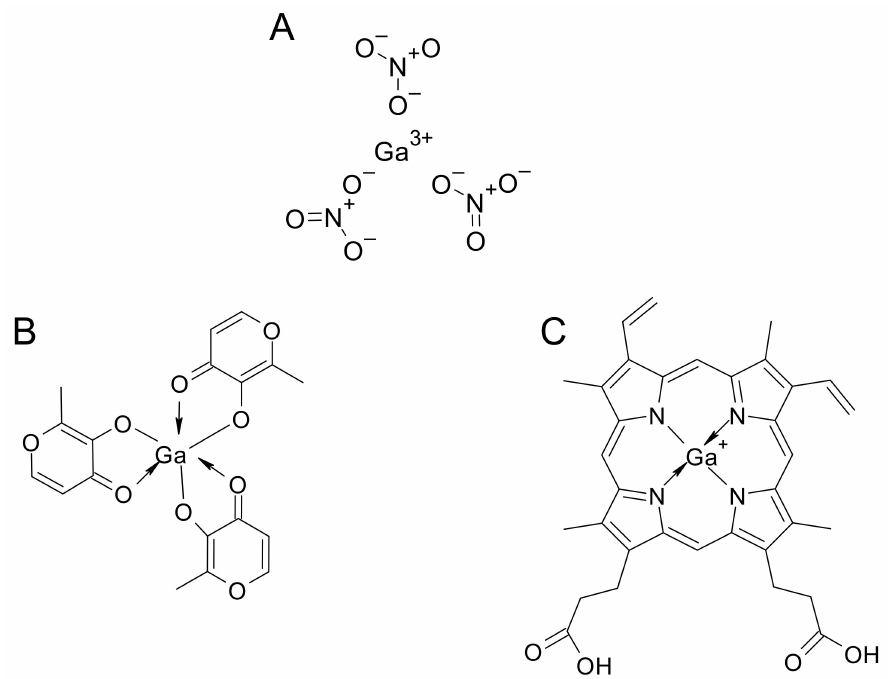
Figure 3. Chemical structures of gallium compounds belonging to the three different groups: ( A ) first-generation gallium nitrate; ( B ) second-generation gallium maltolate; ( C ) third-generation gallium protoporphyrin